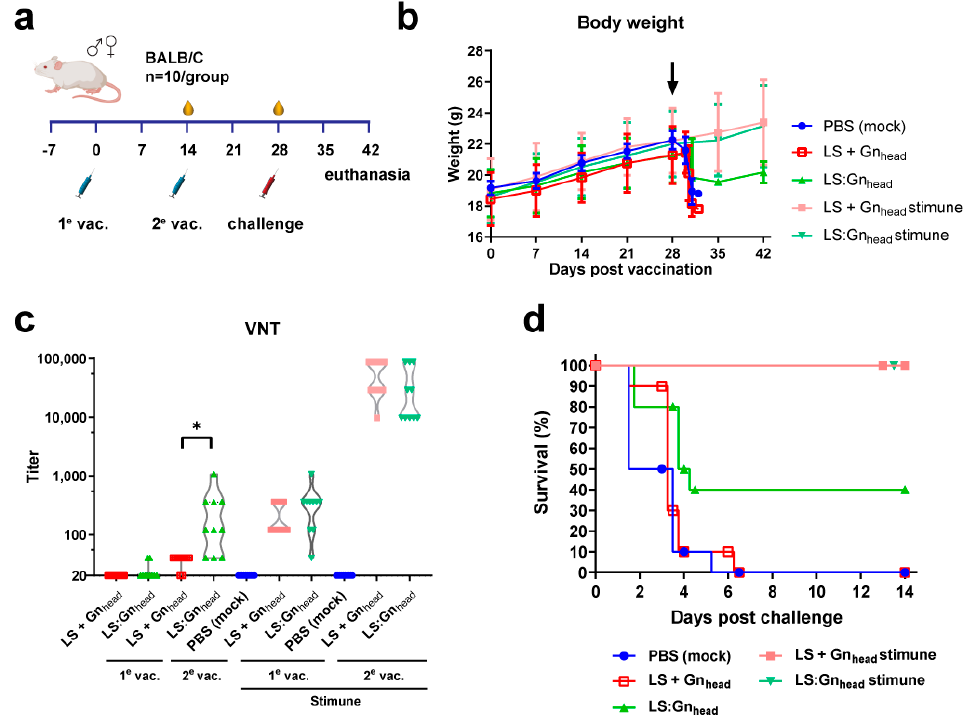
Figure 3. RVFV vaccination-challenge experiment with Gn head -conjugated LS particles in mice. ( a ) Schematic presentation of the experimental setup. ( b ) Average body weights with SD following vaccination (day 0 and 14) and challenge (day 28; black arrow). ( c ) Neutralizing antibodies in serum following the first (day 14) and second vaccination (day 28). The x-axis is set to the limit of detection of the VNT. ( d ) Survival of vaccinated animals following RVFV challenge.